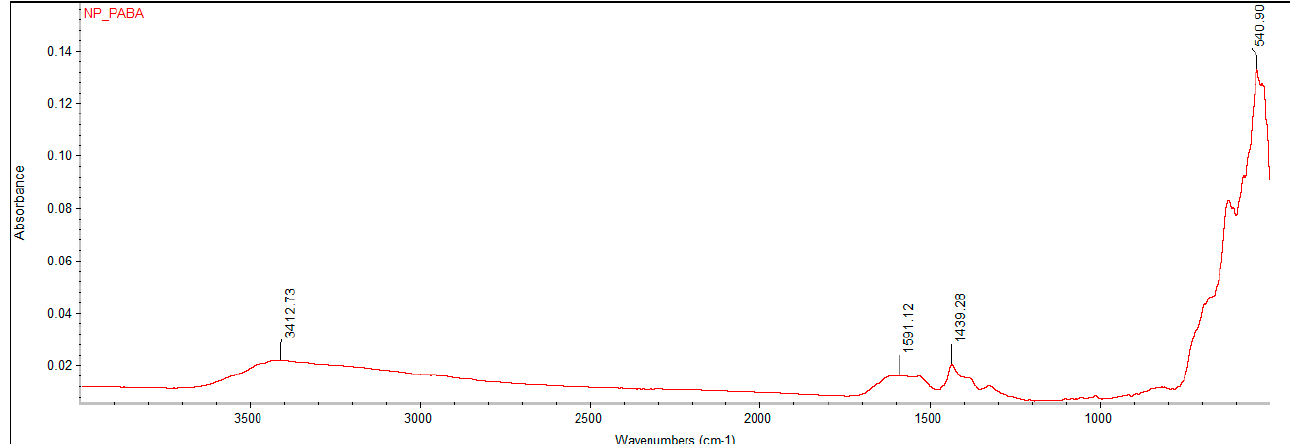
Figure 3. The FT-IR spectrum of Fe 3 O 4 -PABA .